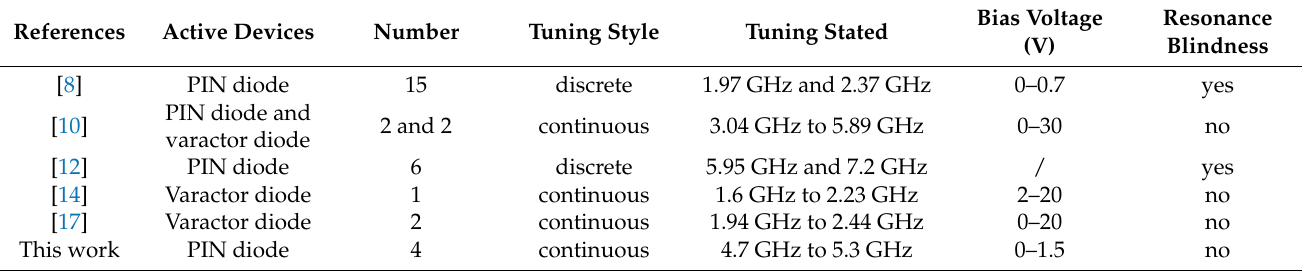
Table 1. Comparison of different types of tuning.